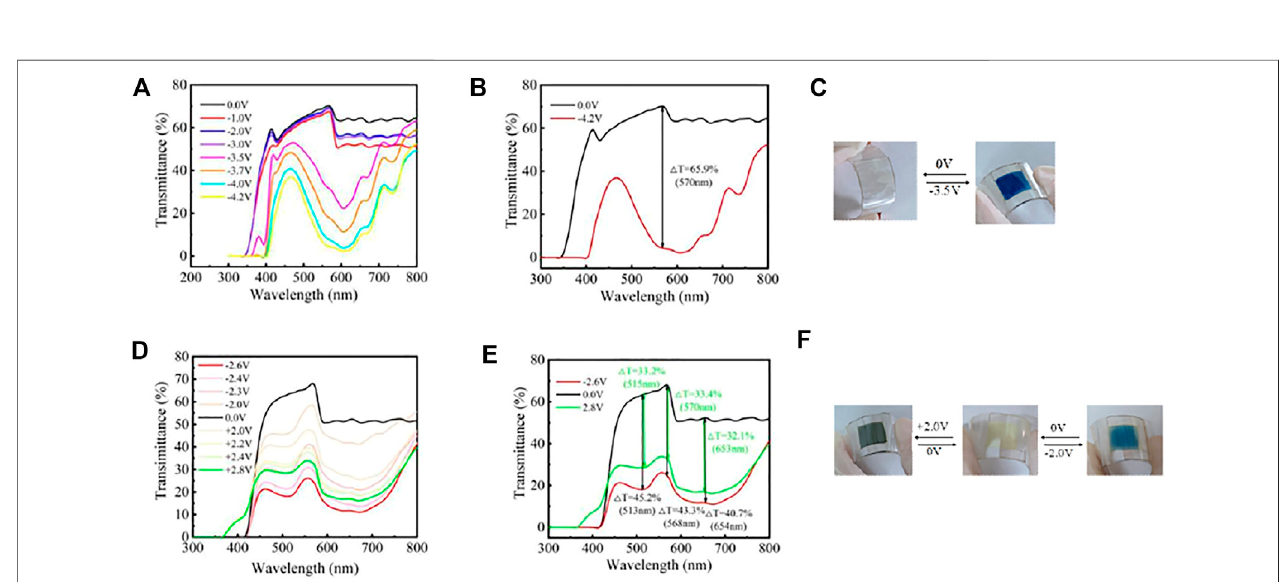
FIGURE 5 | Spectroelectrochemistry ofFECD-EP (A) and FECD-composite (D) . Optical contrast ofFECD-EP (B) and FECD-composite (E) . Color change images of FECD-EP (C) and FECD-composite (F) .